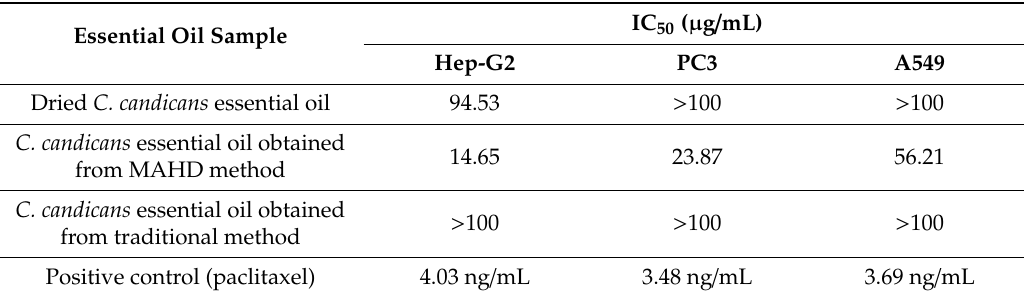
Table 6. Anti-proliferation activity (IC 50 values) of the C. candicans essential oil against three human cancer cell